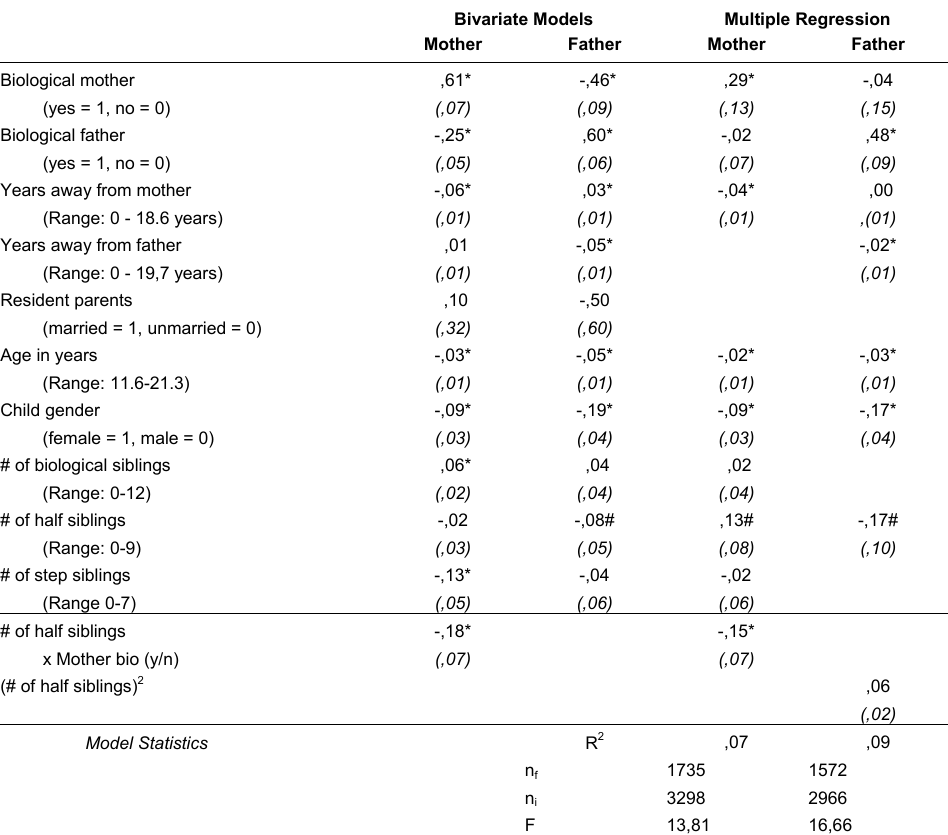
Table 5: Fixed effects regression on children’s assessments of their relationships to their resident fathers and mothers (coefficients and standard errors) Bivariate Models Multiple